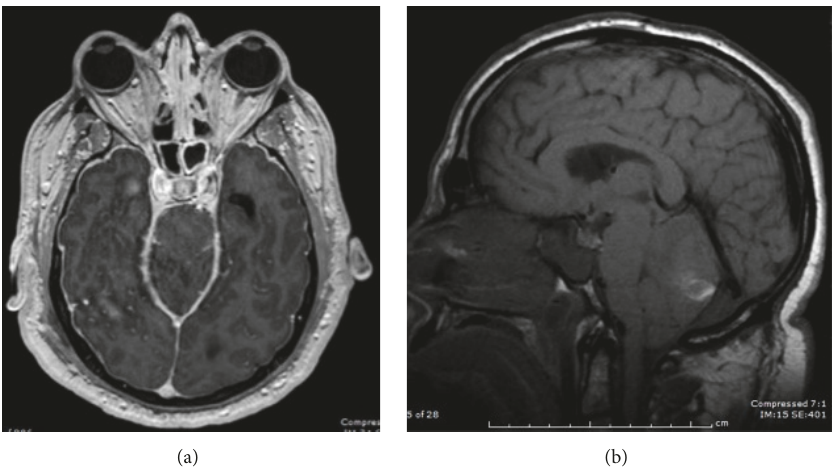
Figure3:MRIbrainwasperformedonthesamedateoftheCThead.Itconfirmed cerebellarhaemorrhageandmasseffectonthe4thventricle and brainstem. (a) Axial T1 SPGR postgadolinium MR image shows diffuse dural enhancement. (b) Sagittal T1 MR image of the brain shows “sagging” midbrain, flattening of the pons against the clivus, and mild cerebellar tonsillar descent. The findings in (a) and (b) are consistent with intracranial